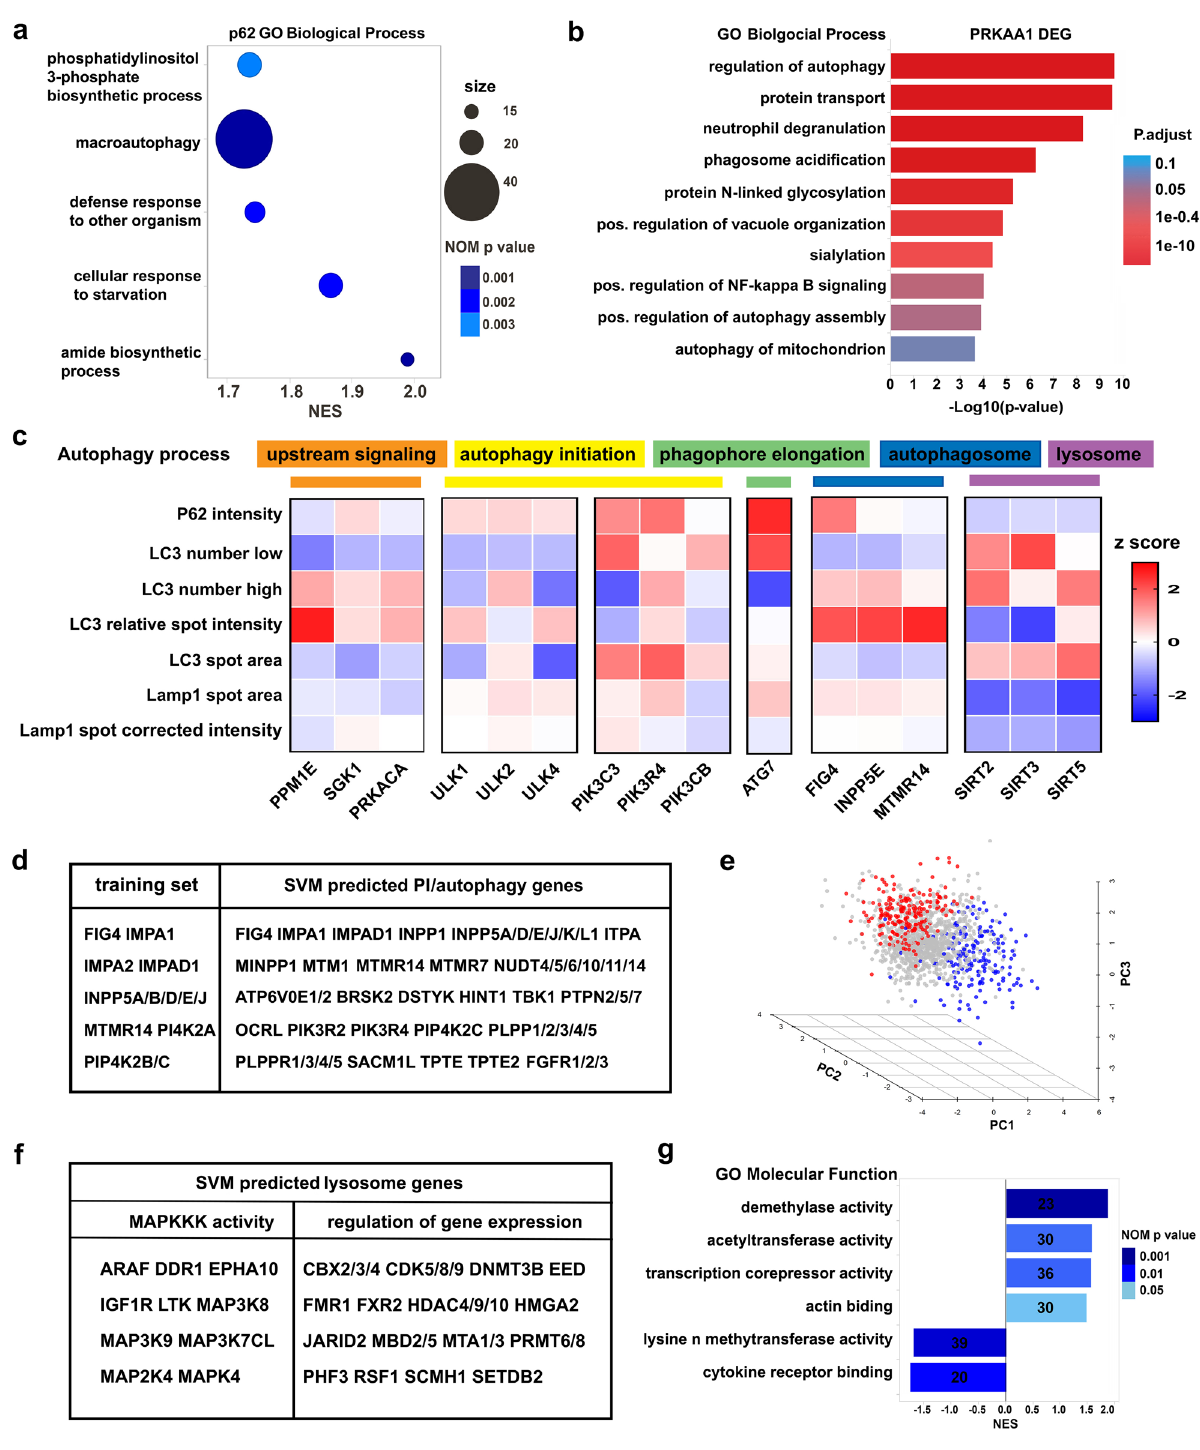
Figure 2. Basal autophagy and lysosome gene discovery via arrayed CRISPR and multi-parameter HCI. ( a ) GSEA analysis of p62 z score ranked gene list reveal enriched GO Biological Processes such as macroautophagy. ( b ) Enrichment analysis of differentially expressed genes upon PRKAA1 CRISPR show perturbed biological processes consistent with its role in autophagy. ( c ) Panel of autophagy related HCI parameters capture distinct patterns for genes involved in different stages of autophagy. d and f, Support-vector machine (SVM) learning was applied to 7-parameter dataset to predict genes that act similarly to phosphoinositol (referred to as PI) related genes in autophagy processes ( d ) and sirtuin genes in lysosome homeostasis ( f ). ( e ) Illustration of SVM method, predicted genes highlighted in red and blue, background is in grey. ( g ) Epigenetic regulators impact lysosome bi-directionally, supported by enriched pathways from GSEA analysis of LAMP1 z score ranked gene